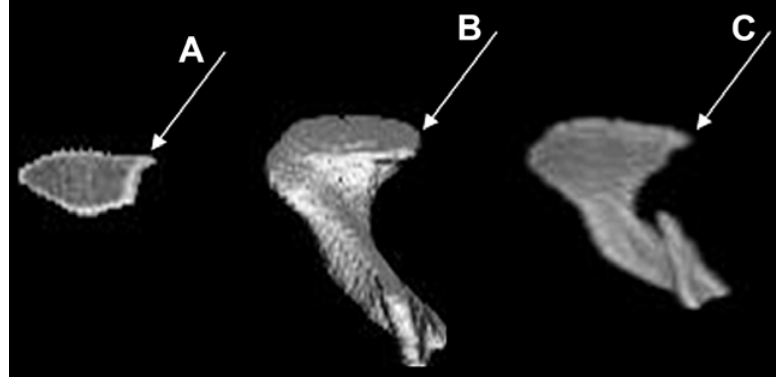
FIGURE 2 - MPR (A), 3DR-SSD (B) and 3DR-MIP (C) images showing osteophyte in the same mandibular condyle